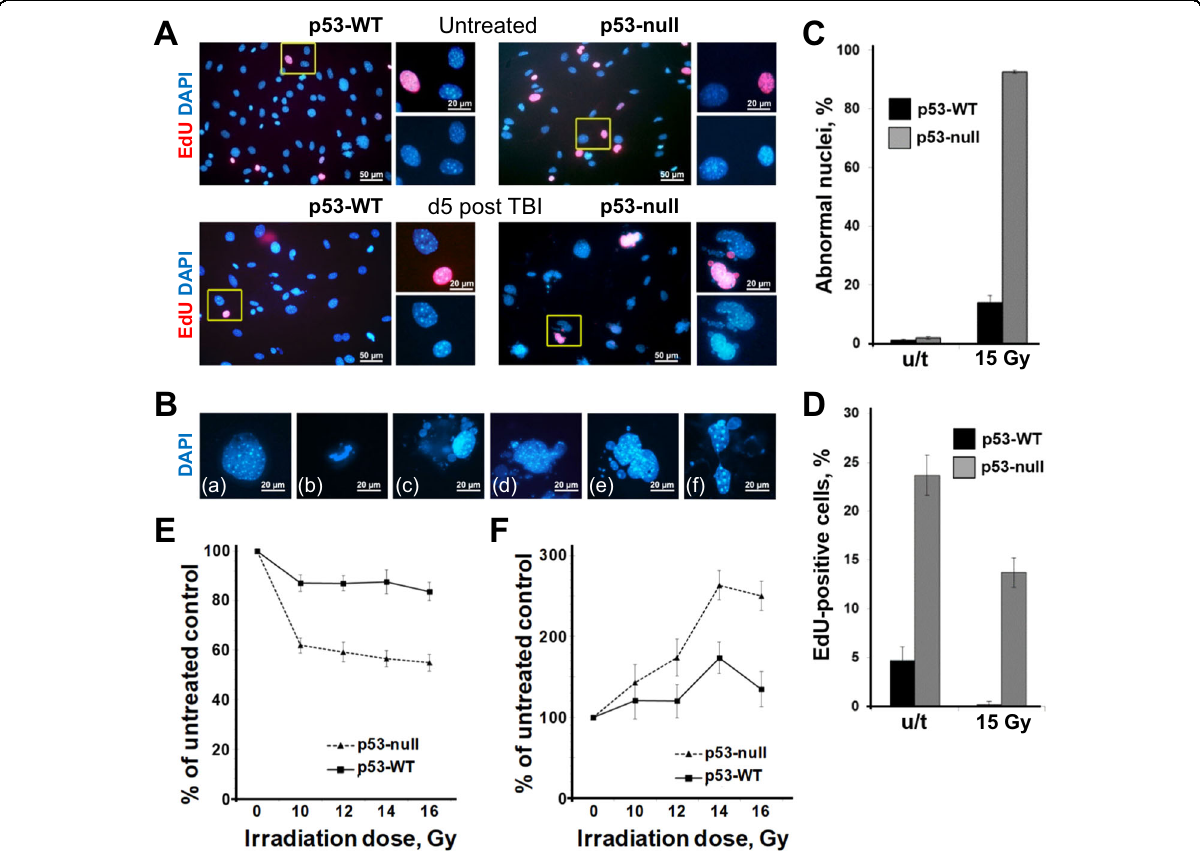
Fig. 6 Bone-adherent mesenchymal cells (BAMC) from p53-null mice are more radiosensitive than those from p53-WT mice. A A number of nuclei with abnormal morphology are higher in p53-null BAMC than in p53-WT BAMC after IR. Cultures of BAMC from p53-WT and p53-null mice were evaluated by immuno fl uorescence before IR (upper panel) or 5 days after in vitro IR (15 Gy) (bottom panel). Cells were stained to detect EdU incorporation and DAPI as a counterstain to visualize nuclei. EdU was added to cell cultures 1h before staining. Data from A (quantitation) are shown graphically in C and D . B Images of individual cells provide examples of abnormal nuclear morphology observed in irradiated p53-null BAMC cultures (15 Gy, 5 days). Nuclei in p53-null cells had different morphological types of abnormalities including (a) abnormally large nuclei, (b) condensed nuclear chromatin, (c) micronuclei, (d) nuclear budding, (e) large multilobed nuclei, (f) chromatin bridge. C , D Percent of EdU + nuclei and abnormal nuclei relative to total cells was determined by counting cells under microscope in randomly selected areas (at least 500 nuclei of each sample). (Mean± SD for three replicates from one BAMC culture). The difference in % of EdU between p53-KO and p53-WT BAMC was statistically signi fi cant ( p < 0.003 for cells before irradiation, and p < 0.006 for cells after irradiation two-sided t test). The difference in % of abnormal nuclei between p53-KO and p53-WT BAMC was statistically not signi fi cant before IR, and signi fi cant after IR ( p < 0. 0003 by two-sided t test). E , F BAMC were isolated from p53-null and p53-WT mouse femurs, expanded in vitro (three passages), and irradiated with different doses of IR (0 – 16 Gy). Cell viability was determined 72 h after IR by ATP assay ( E ) or by protease activity assay (CellTox Green assay) ( F ) and is shown relative to viability of untreated (non- irradiated) control cultures (mean± SD for three replicates from one BAMC culture). The difference in viability between p53-KO and p53-WT BAMC was statistically signi fi cant ( p < 0.05, two-sided t test) for all IR doses by ATP assay and for doses > 12 Gy by CellTox Green